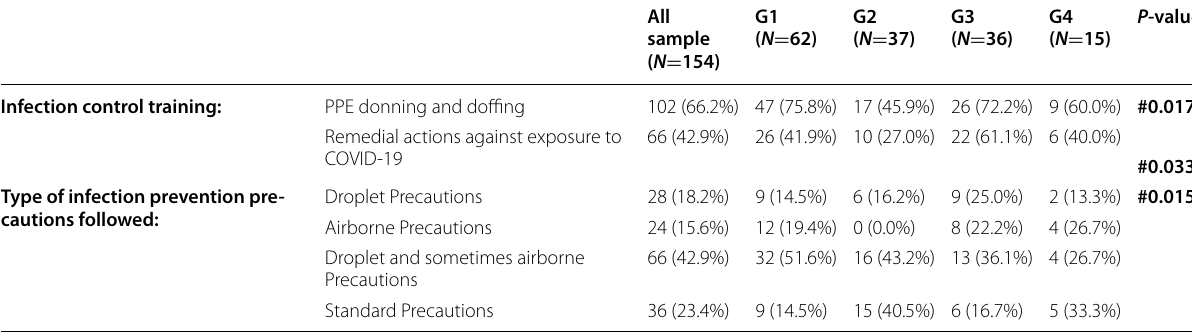
G1 (Western European), G2 (Middle Eastern), G3 (Latin American), G4 (Eastern European) countries’ participants #Chi-square test.